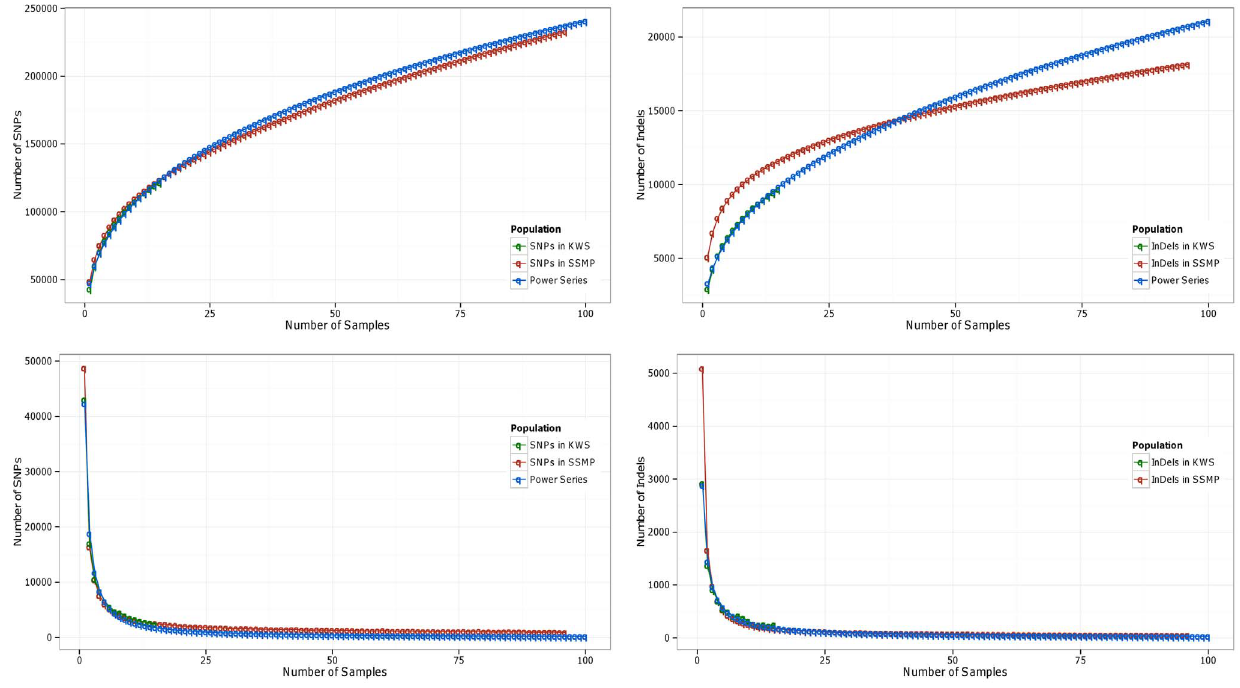
Figure 5. Distribution of total number of variants (SNPs and indels) upon step-wise addition of exomes, and the distribution of number of new variants added per exome. (Coefficient of determination (R 2 ) . 0.99 for all fitted curves).